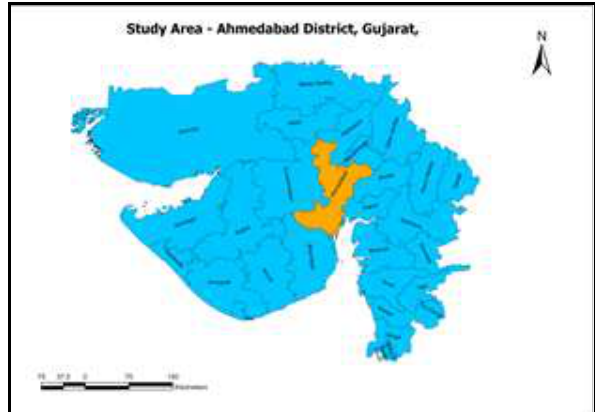
Figure 1 Study Area of Ahmedabad district